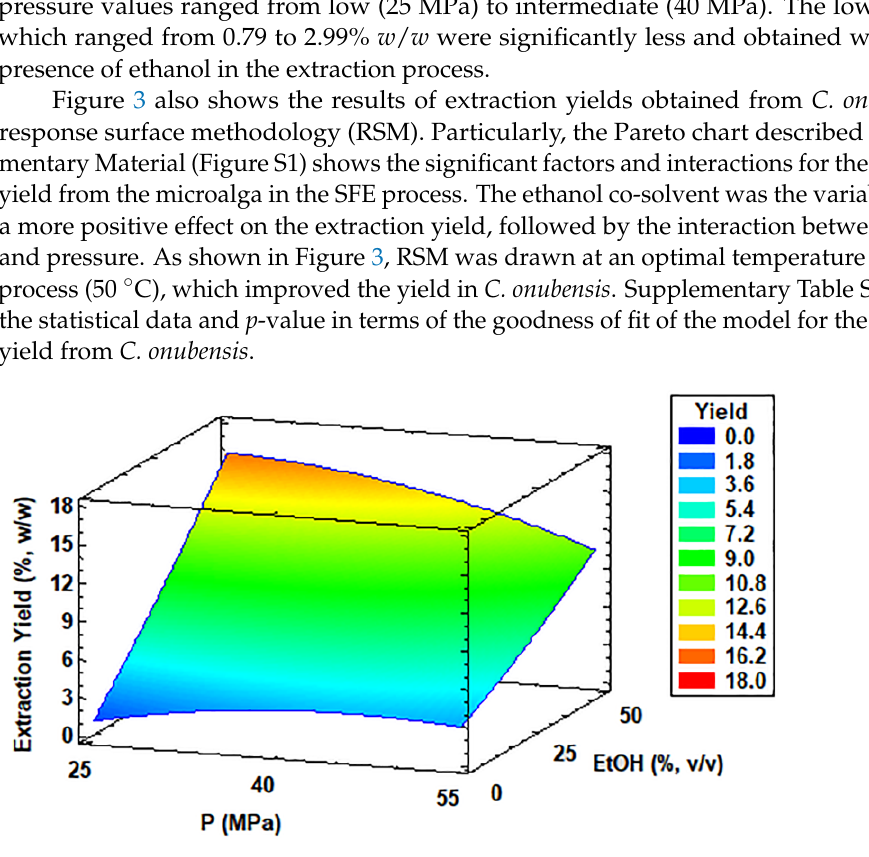
Figure 3. Response surface curve of the combined effects of temperature (30–70 °C), pressure (25–55 MPa), and ethanol as co-solvent (0–50% v / v ) on extraction yield from Coccomyxa onubensis . Response surface curves were drawn from the viewpoint of the optimal temperature (50 °C). Abbre- viation: temperature (T); pressure (P); and ethanol as co-solvent (EtOH).